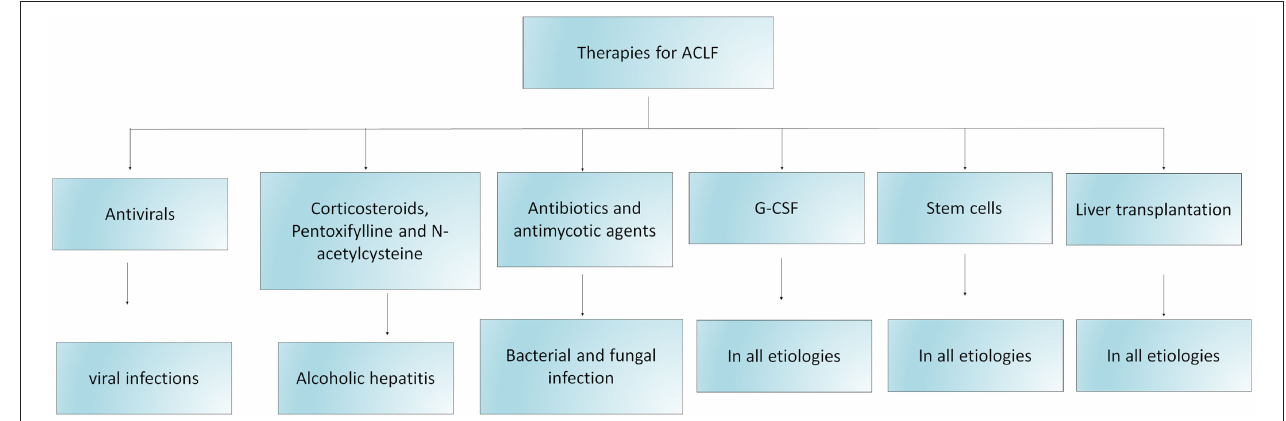
FIGURE 3 | Schematic diagram indicating therapeutic strategies for the management of ACLF. The figure demonstrates different treatment options for patients with ACLF based on their etiology, precipitating events, complications and the requirement of liver transplantation. Several clinical trials are investigating the efficacy of stem cell therapy as one of the potential therapeutic approach for the treatment of ACLF. G-CSF: granulocyte macrophage colony stimulating